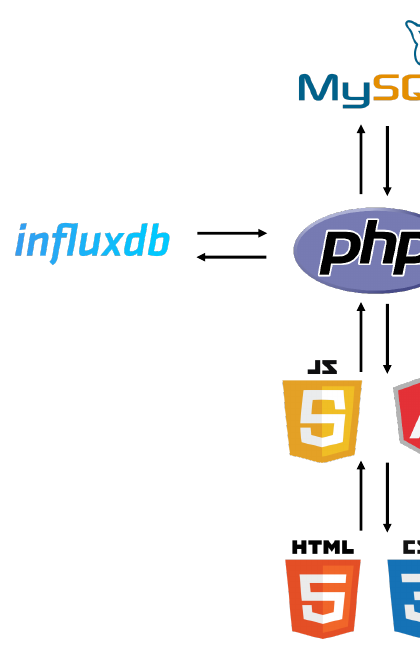
Figure 6. Technical specifications of the